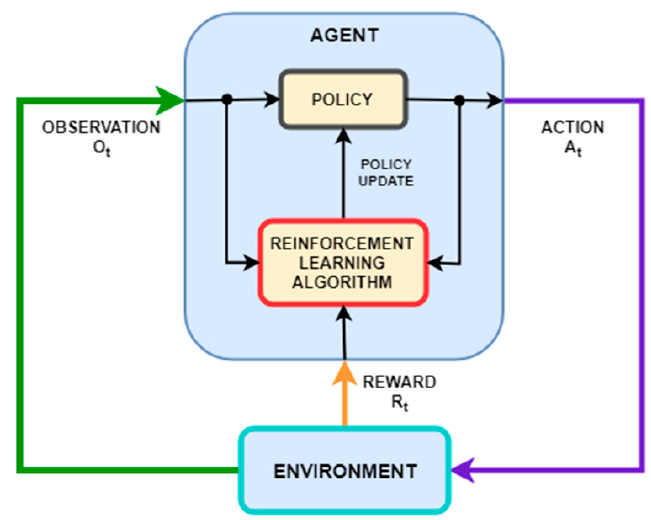
Figure 16. Reinforcement Learning Block Diagram [26].